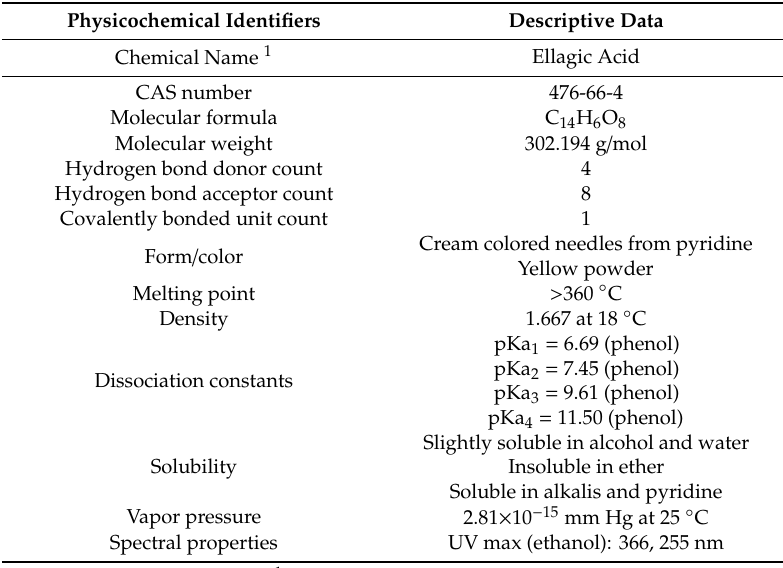
Figure 3. Structure of two metabolites of ETs: ( a ) gallic acid (GA); ( b ) ellagic acid (EA). Table 6. Chemical and physical properties of EA [40,58].